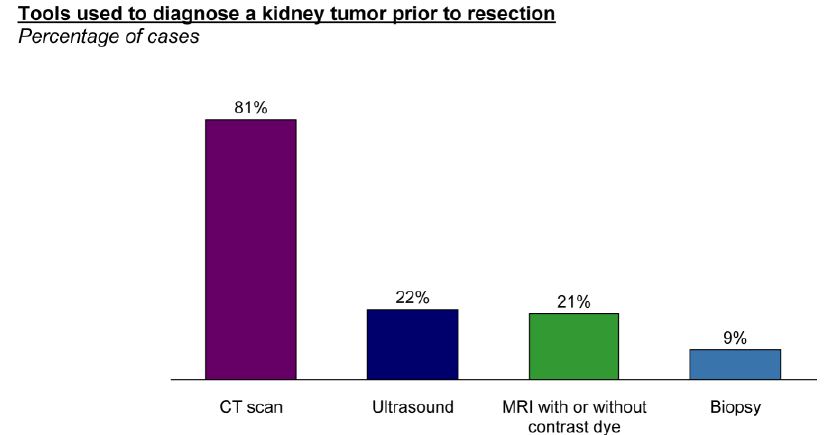
Figure 1 . Frequency of use of pre-nephrectomy diagnostics in U.S. today.